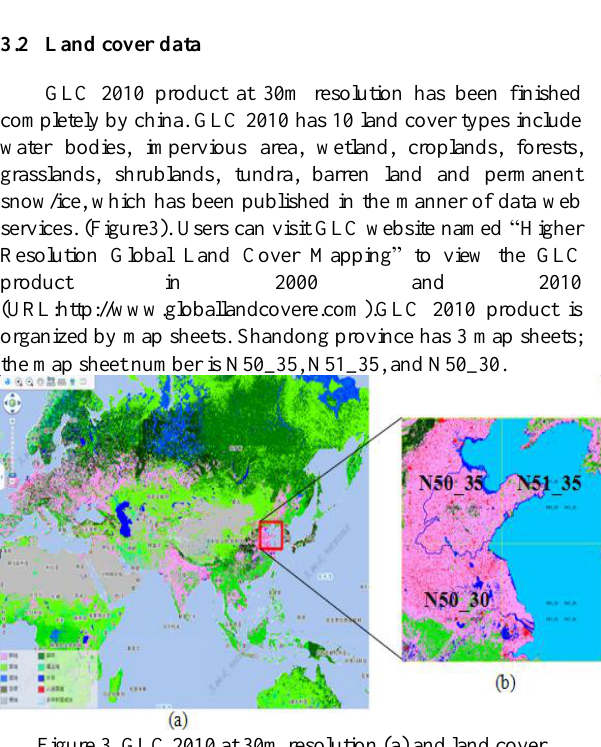
Figure 3. GLC 2010 at 30m resolution (a) and land cover product in Shandong province (b)